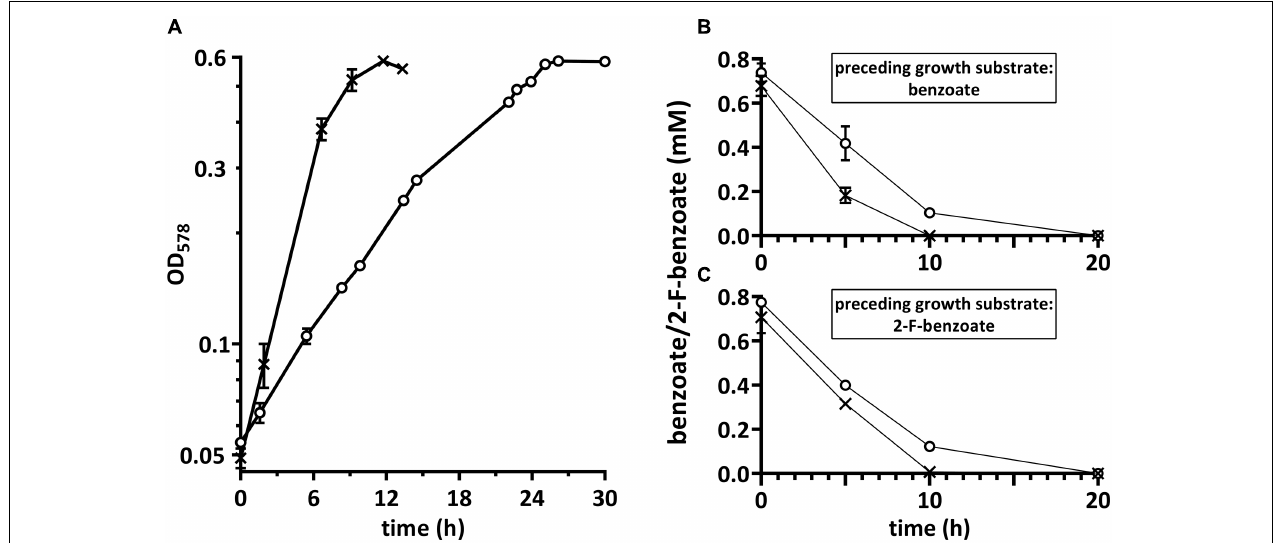
) and benzoate ( × ), and the consumption of both of these substrates by suspensions of FIGURE 2 | (A) Growth of Thauera aromatica K172 with 2-F-benzoate ( cells grown with (B) benzoate or (C) 2-F-benzoate. Both substrates were consumed by either type of cells as indicated by decline of their concentrations. (cid:35) Corresponding data points were connected for comprehensible visualization. The y -axes show concentrations of benzoate/2-F-benzoate added to the cell suspensions. Means of two biological replicates are shown.